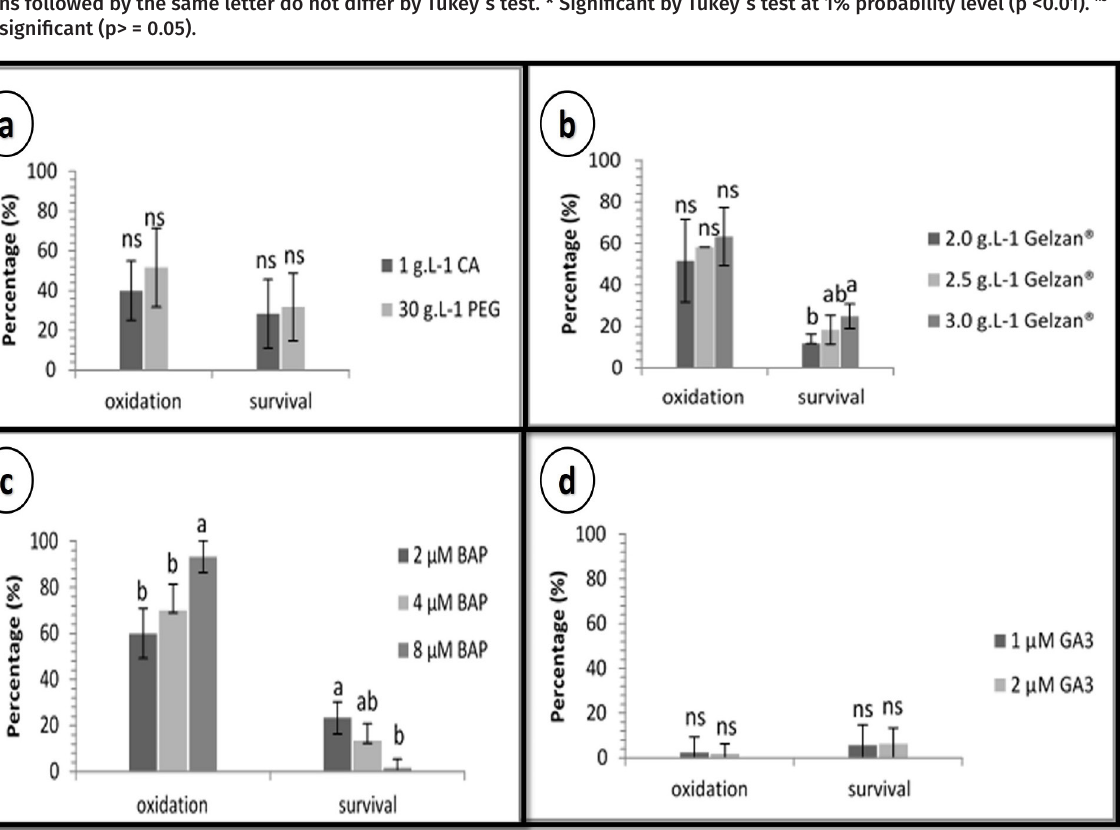
Figure 3. Oxidation and survival of somatic embryos of Plinia cauliflora cultivated in MS medium for 30 days in function of the addition to the maturation culture medium of AC or PEG (a), Gelzan (b), BAP (c) and BAP (0.5 μM) with GA (d). Columns with the same letter do not differ significantly by Tukey´s test at 5% 3